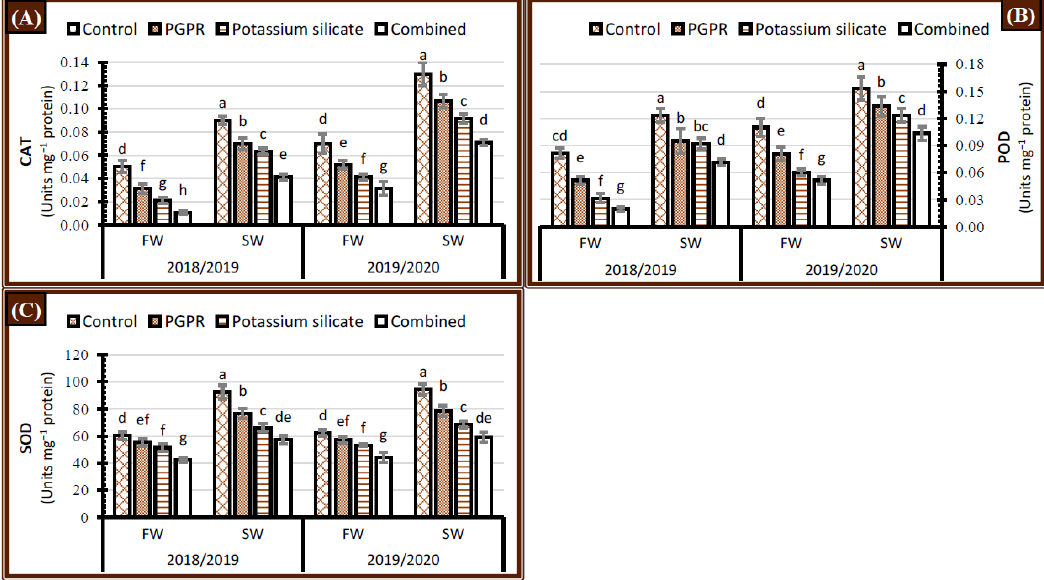
Figure 4. Effect of application of PGPR, potassium silicate and their combination on the activity of antioxidant enzymes ( A ) catalase (CAT), ( B ) peroxidase (POD) and ( C ) superoxide dismutase (SOD) in the leaves of faba bean plants grown under two irrigation types, i.e., fresh water (FW) and saline water (SW) in salt-affected soil during two growing seasons 2018/2019 and 2019/2020. The data are means ± SD of four replicates. Means values that have the same lower-case letter in each column per season are not significant according to Duncan’s Multiple Range